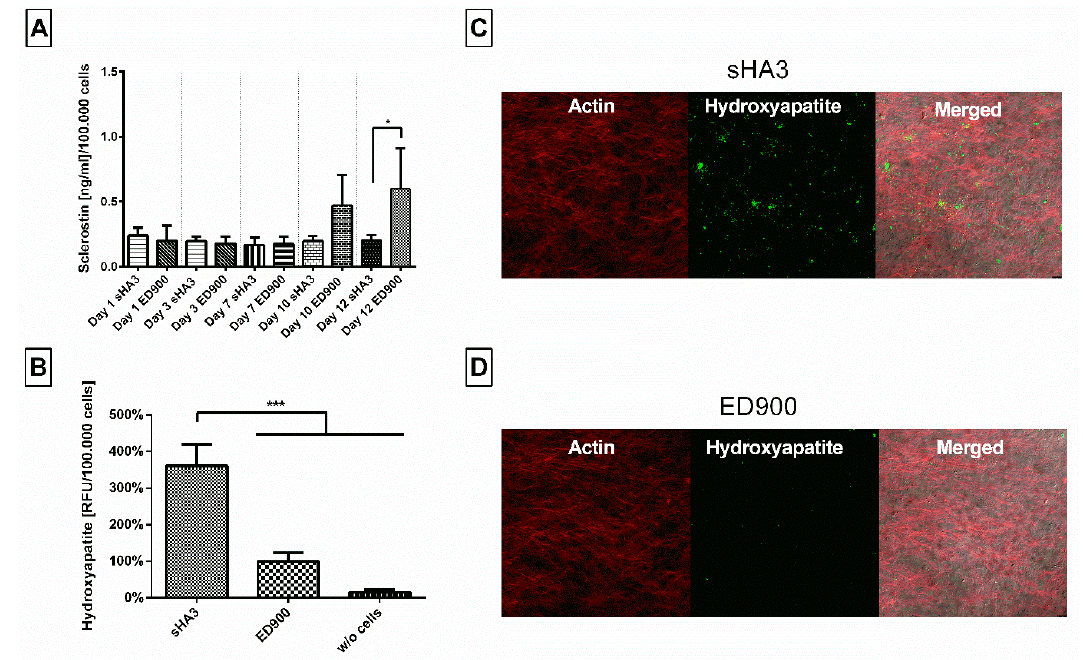
Figure 10. E ff ect of film modification on secreted protein content in the supernatant and mineralization during osteogenic di ff erentiation of hMSC. Cells were seeded on di ff erently modified surfaces at a density of 15,000 / cm 2 and di ff erentiated for 12 days. ( A ) Sclerostin was then quantified from the cell supernatant via ELISA after 1, 3, 7, 10, and 12 days. OsteoImage TM staining was assessed at day 12 and the fluorescence signal quantitatively ( B ) and qualitatively( C , D ) analyzed. Film surfaces: ED900: surface coating with ED900 preincubated with soluble sHA3; sHA3: covalent ED900 and sHA3-coating; w / o cells: sHA3 surface without seeded cells. All values represent the mean ± SD of n ≥ 4. * p < 0.05; *** p < 0.001 denotes significant di ff erence vs. the respective surface modifications.